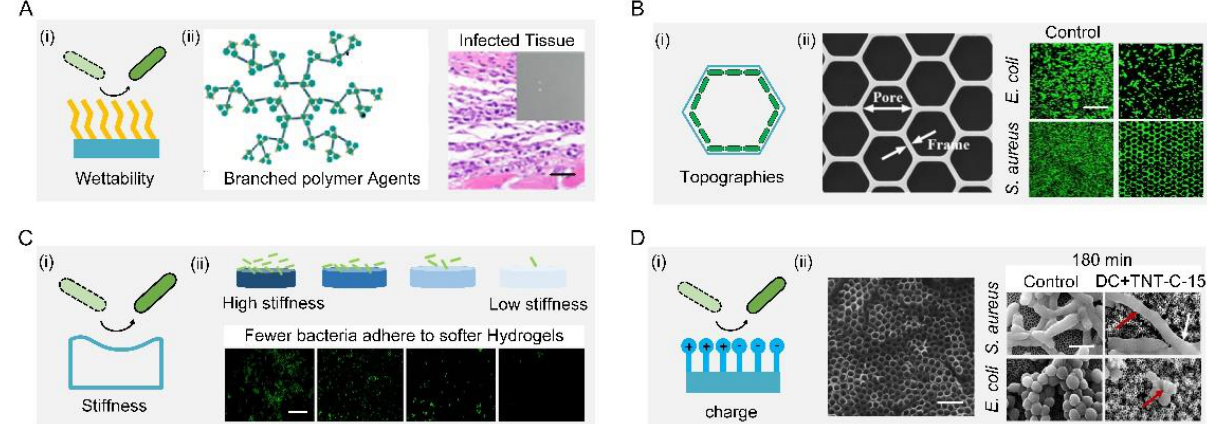
Figure 4. Bacteria-repellent surfaces. ( A ) Surface hydrophilization by modifying antibiofouling polymer ( i ) antibiofouling polymeric agents and their application for the surface functionaliza- tion of Ti substrate; the resultant surface can effectively repel bacterial adhesion in vivo ( ii ). Scale bar: 100 µ m. Reproduced with permission [80]. 2018, American Chemical Society (United States). ( B ) Schematic diagram of topographies’ surfaces ( i ) SEM and fluorescent images of selective adhesion of bacterial cells on the honeycomb platform ( ii ). Scale bar: 50 µ m. Reproduced with permission [84]. 2015, Elsevier. ( C ) Schematic diagram of stiffness surface ( i ) schematic diagram of the antifouling property of stiffness surface ( ii ). Scale bar: 10 µ m. Reproduced with permission [88]. 2015, American Chemical Society (United States). ( D ) Schematic diagram of charge surface ( i ) Scale bar: 500 nm. Schematic diagram of the antifouling property of charge surface ( ii ) Scale bar: 2 µ m. Reproduced with permission [89]. 2018, Nature Portfolio.